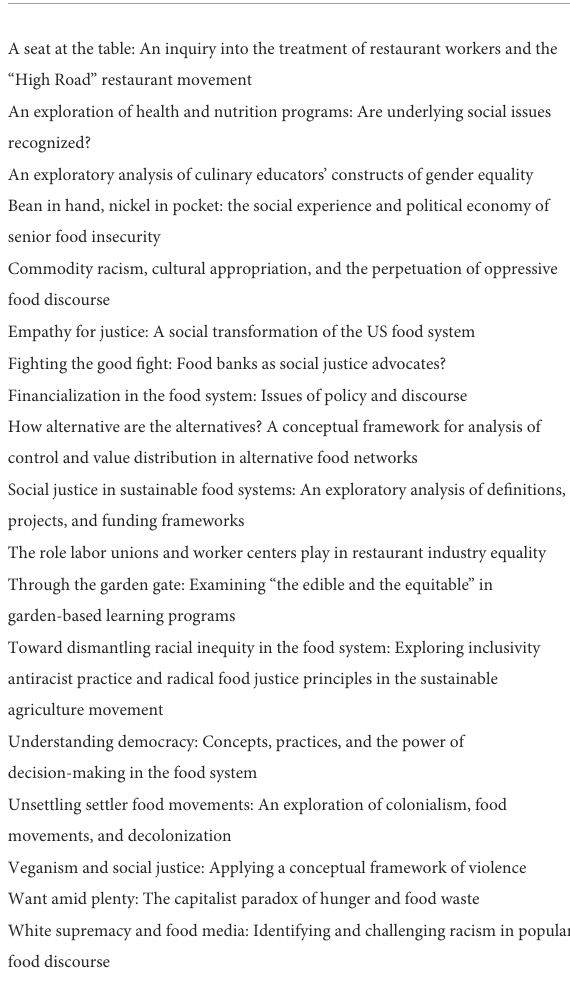
TABLE 3 Selected Capstone Research Synthesis (CRS) titles from food systems and society program graduates.